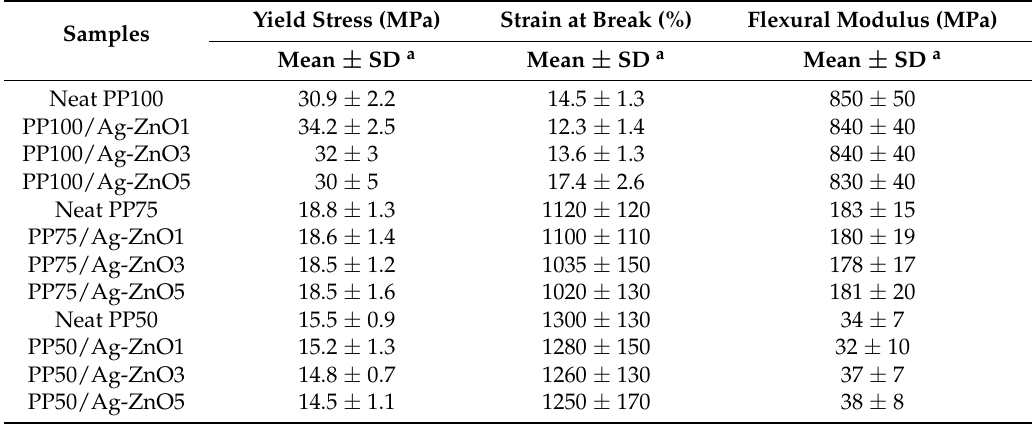
Table 2. Mechanical properties of the